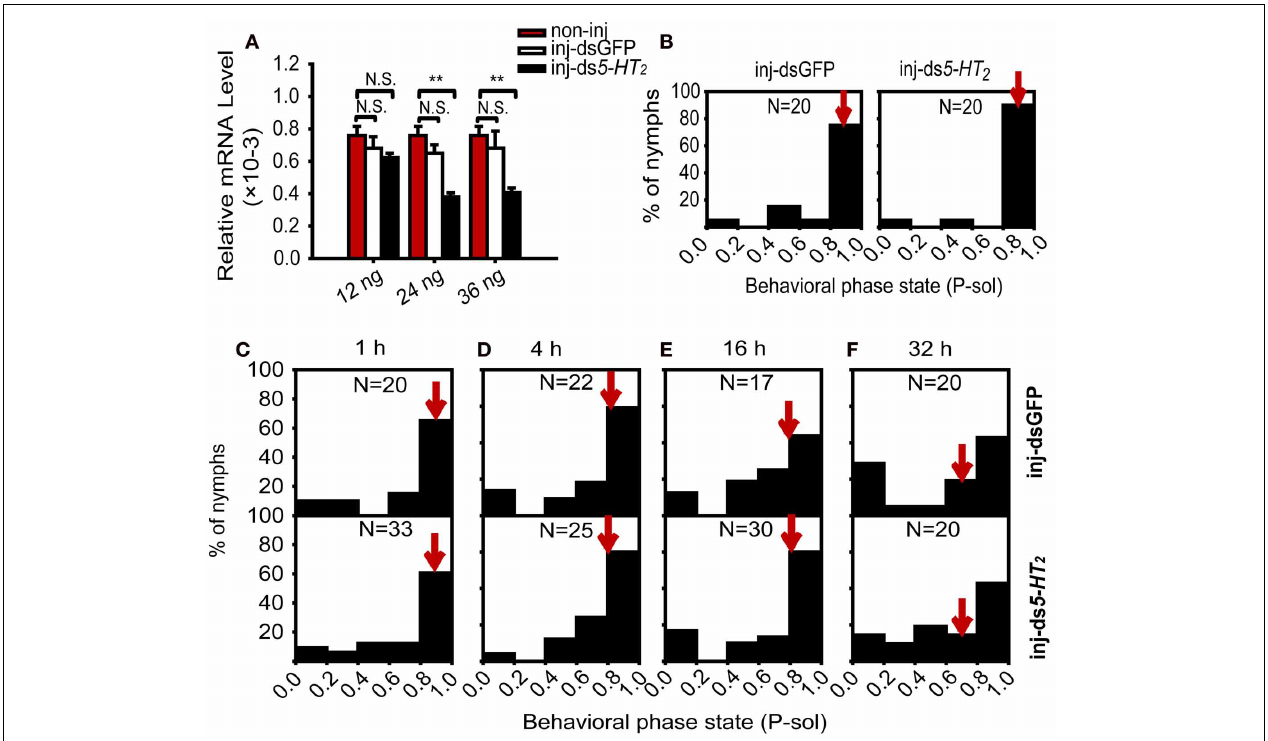
FIGURE 7 | Behavioral responses of solitary nymphs after RNAi knockdown of 5-HT 2 . (A) Effects of RNAi on the relative mRNA level [Student’s t -test, t ( 0 . 05 / 2 , 14 ) = 1 . 656, P = 0 . 129 for 12ng; t ( 0 . 05 / 2 , 14 ) = 6 . 226, P < 0 . 001 for 24ng; t ( 0 . 05 / 2 , 14 ) = 5 . 553, P < 0 . 001 for 36ng]. In all groups, treatment (inj-GFP, inj-ds 5-HT 2 ) compared with the corresponding non-injected controls. The data represent mean